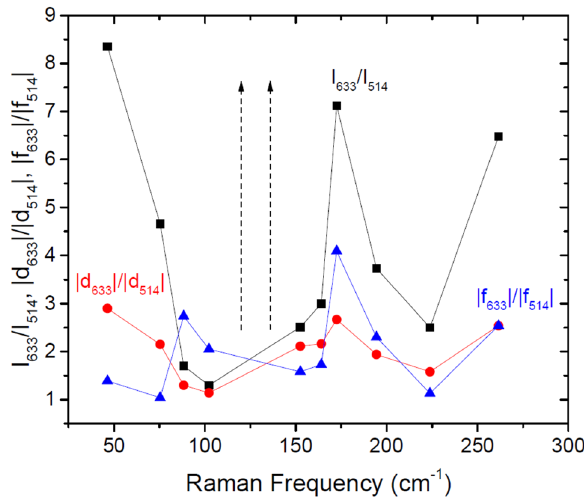
Figure 6. Plot of I 633 /I 514 (black sqares), |d 633 |/|d 514 | (red circles), and |f 633 |/|f 514 | (blue triangles) as a function of phonon energy for A 1 modes. Vertical arrows show modes which are only seen for 633 nm